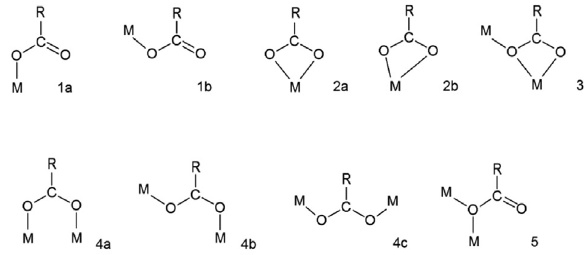
Figure 1. Various carboxylate coordination modes: syn monoden- tate (1a), anti monodentate (1b), syn-syn symmetric chelate (2a), syn-syn asymmetric chelate (2b), chelating bridging (3), syn-syn bridging (4a), syn-anti bridging (4b), anti-anti bridging (4c), mo- noatomic bridging (5).